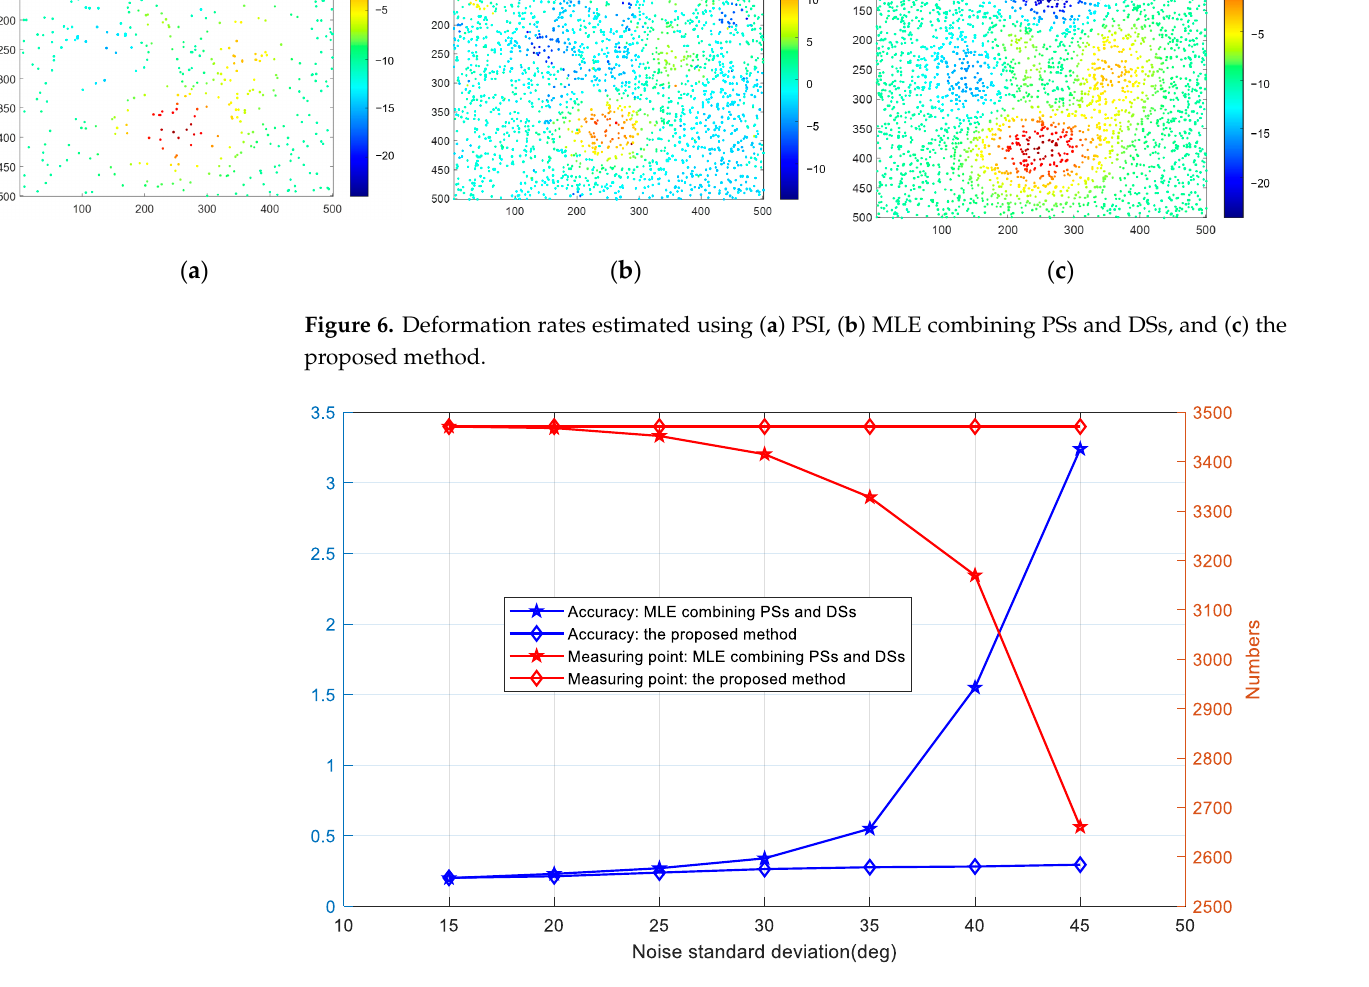
Figure 6. Deformation rates estimated using ( a ) PSI, ( b ) MLE combining PSs and DSs, and ( c ) the proposed method.